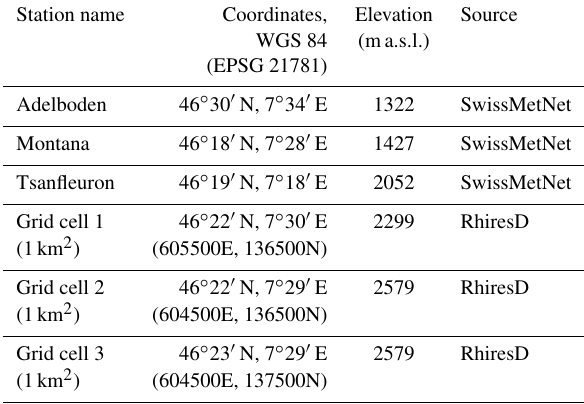
Table 2. Table with three meteorological stations with precipitation measurements and three grid cells of the gridded precipitation prod- uct. For the gridded precipitation, the coordinate in EPSG 21781 represents the center of the corresponding pixel (see Fig.